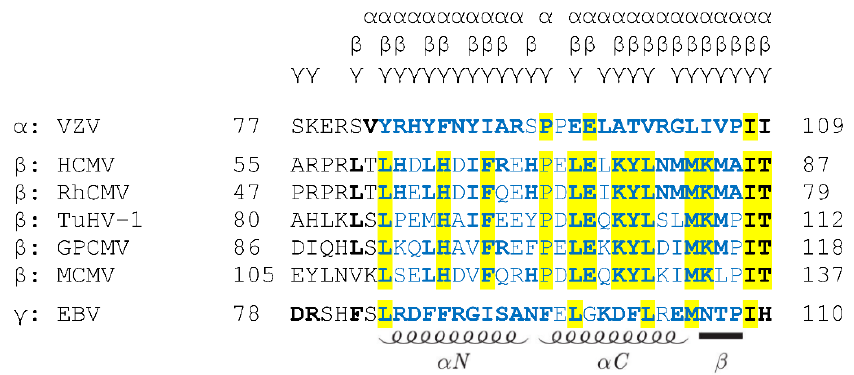
Figure 6. Lack of a simple correlation between the contact amino acids of hook-into-groove interfaces (marked by letters on top) and the amino acids strictly conserved across α -, β - and γ -herpesviral nuclear egress proteins (marked by yellow shading). Amino acid sequence alignment of the hook sequences of several human and animal herpesviral pUL53 homologs. Conserved amino acids are shaded in yellow (i.e., fully conserved between the analyzed β -herpesviruses), the hook-determining amino acids are in blue, and the elements of secondary structure are depicted schematically below the alignment. The hook-into-groove contact residues of VZV, HCMV and EBV are in bold and additionally labeled by the letters α, β and γ on top of the alignment. Amino acids of the animal β -herpesviruses identical to the contact residues of HCMV are also in bold. The numbers represent amino acid positions. UniProt accession numbers: VZV, P09283; HCMV, P16794; rhesus cytomegalovirus (RhCMV), O71122; herpesvirus tupaia (TuHV-1), Q91TN5; guinea pig cytomegalovirus (GPCMV), U6H9V2; MCMV, D3XDP1; EBV, P0CK47.